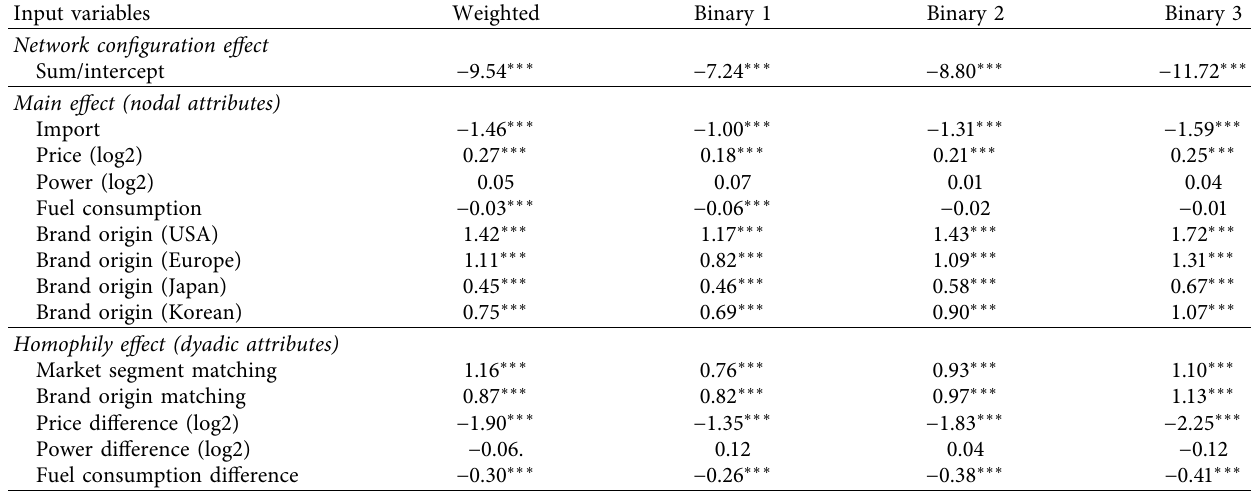
Table 2: Estimated coefficients of the 2013 co-consideration network for a weighted network and binary networks. Input